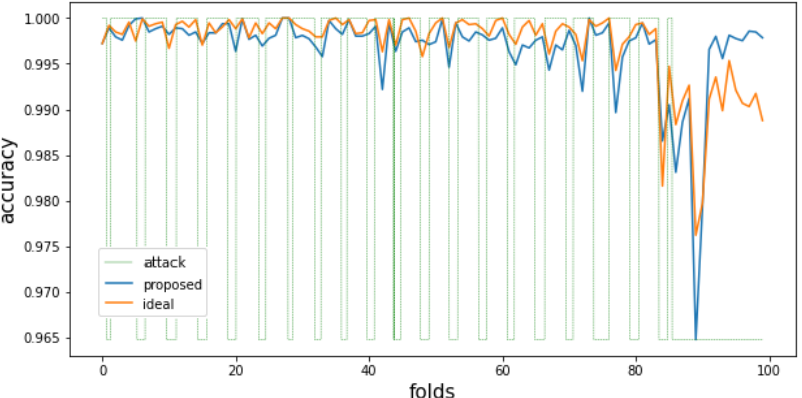
Figure 7. Attack classification accuracy of the proposed method and the ideal method when the size of the pure dataset is 40,000.